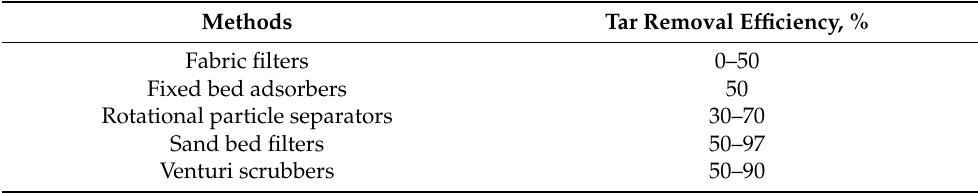
Table 8. Methods of tar reduction